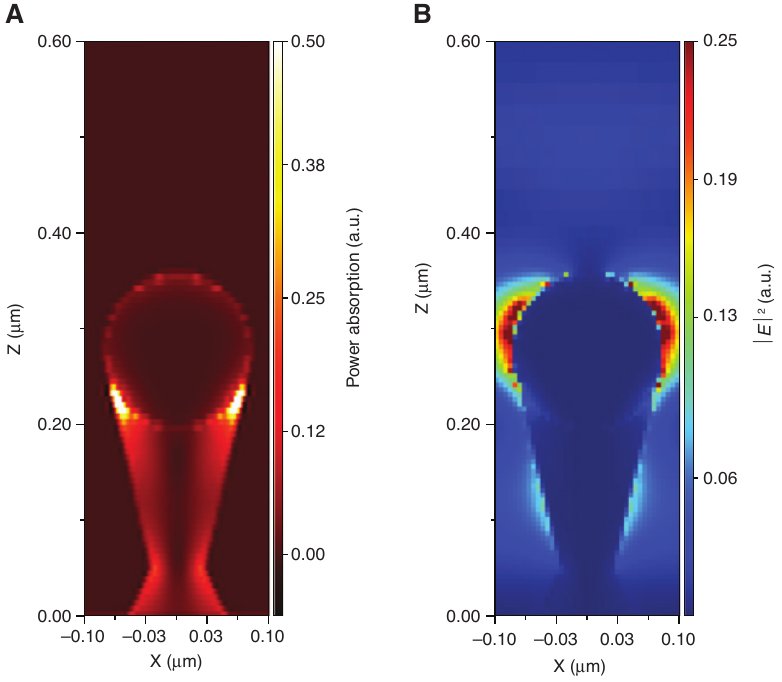
Figure 5: Power absorption and electric field intensity profiles of an In/InP nanopillar. The cross-section profile of (A) power absorption and (B) electric field intensity (| E | 2 ) for a pillar with a height of ~ 340 nm at an incident light wavelength of 445 nm clearly show absorption within the pillars and presence of a HE -like mode in the tapered InP nanopillar. Both the 1m profiles have been normalized to the maximum value of the respective parameters. To enhance the profile within the pillars, the parameter values were saturated to 0.5 for the power absorption profile and 0.25 for the electric field intensity profile.